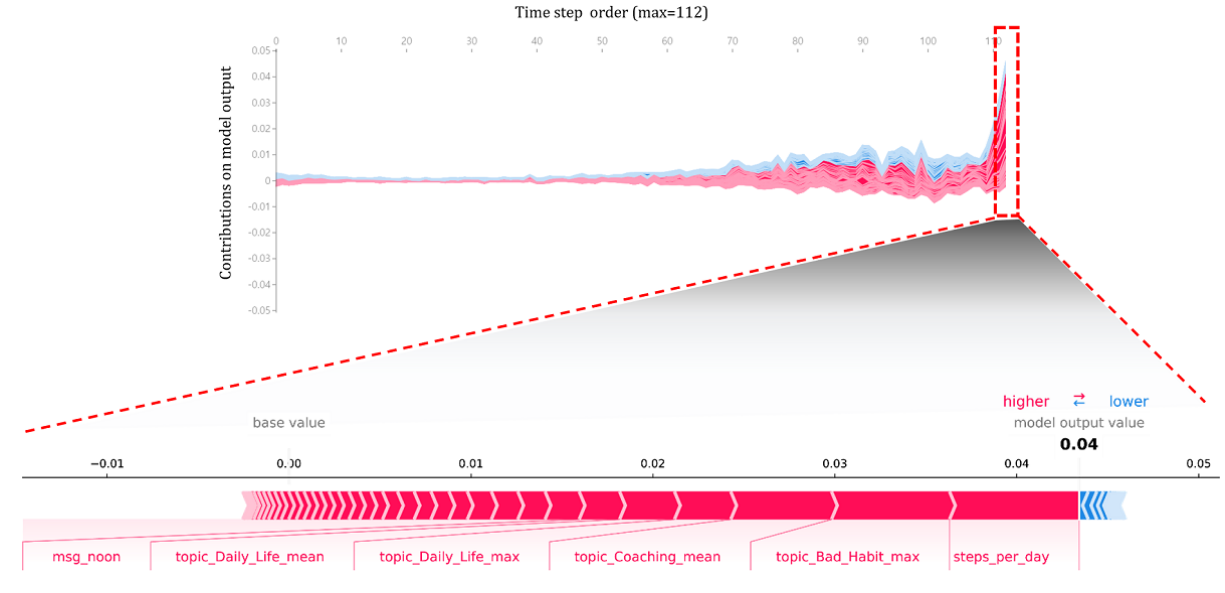
Figure 4. Churn users’ daily average contribution of variables over time (above, line plot) and contributions of each variable on the last day (below, bar